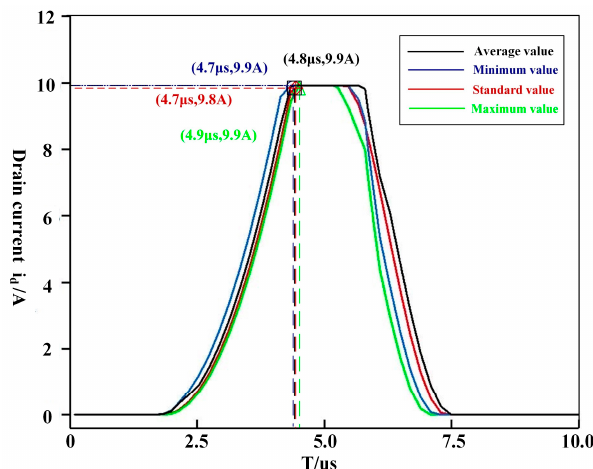
Figure 13. Simulation curves of i d and the maximum value, standard value, average value and minimum value of R g .